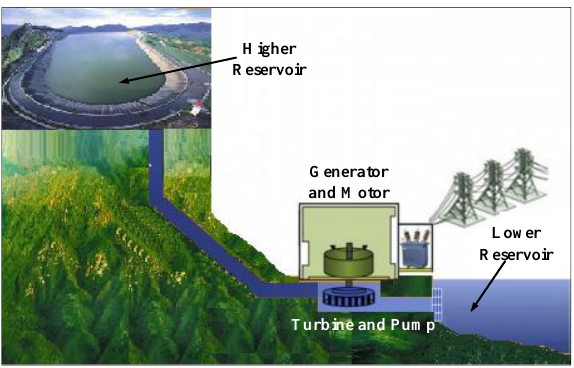
Figure 2. Pumped hydroelectric storage.